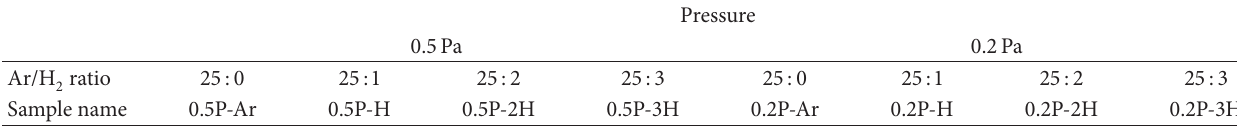
Table 1: Sample names of ZnS thin films deposited in different sputtering atmosphere.